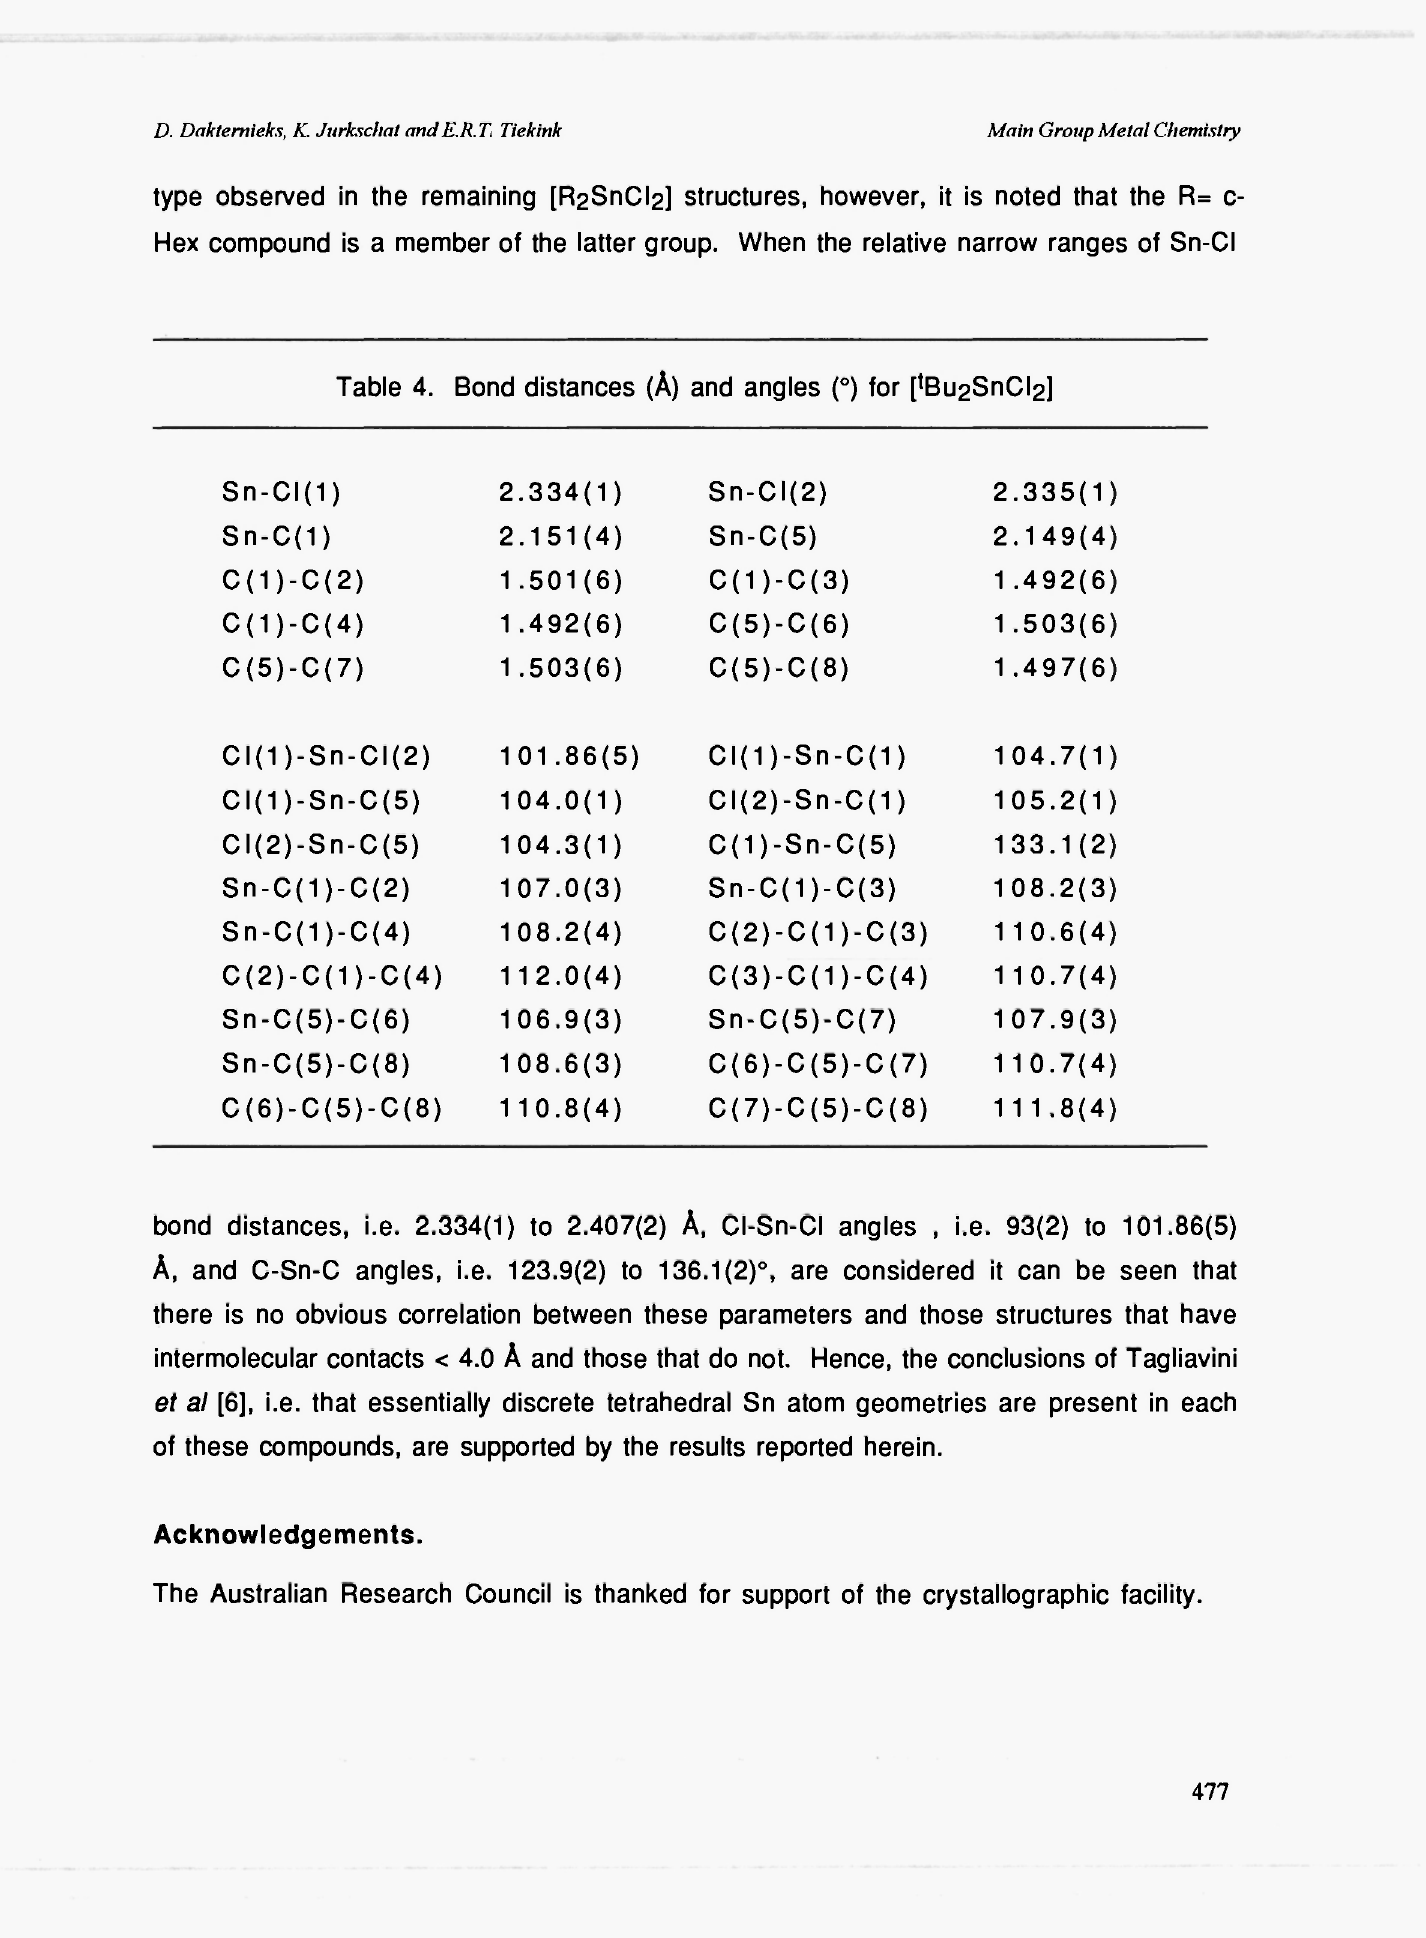
Table 4. Bond distances (A) and angles (°) for [ ,